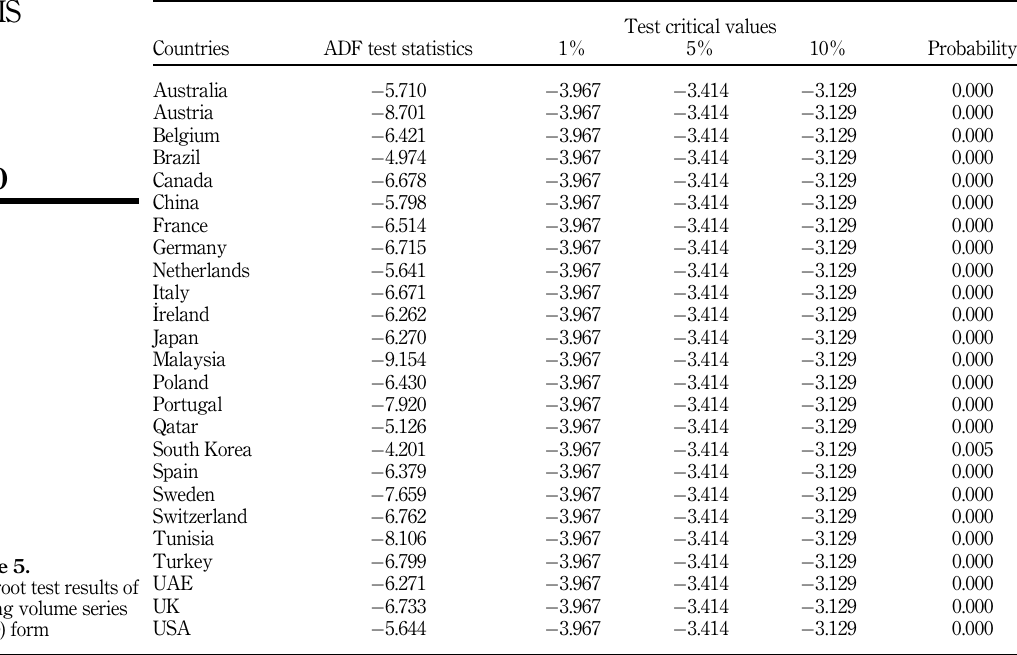
Table 5. Unit root test results